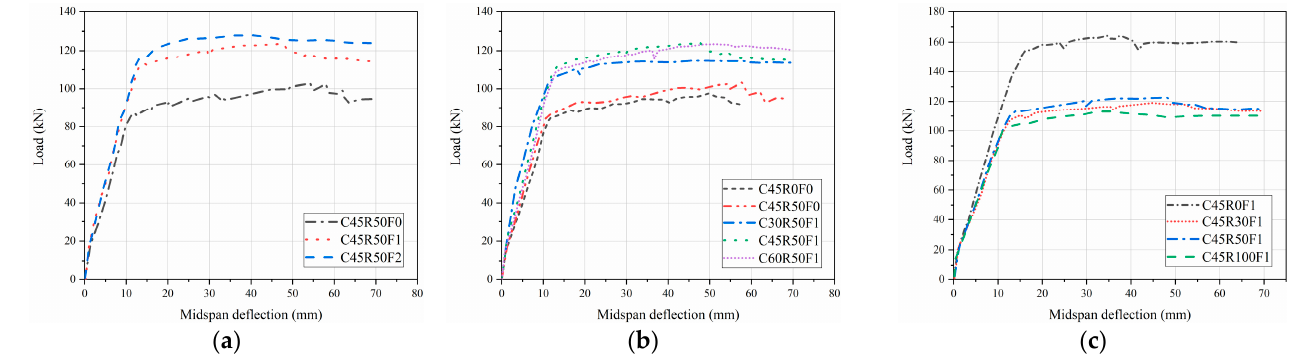
Figure 9. Load–deflection curves of the tested beams. ( a ) Steel fiber volume fraction, ( b ) concrete strength, ( c ) recycled aggregate replacement ratio.